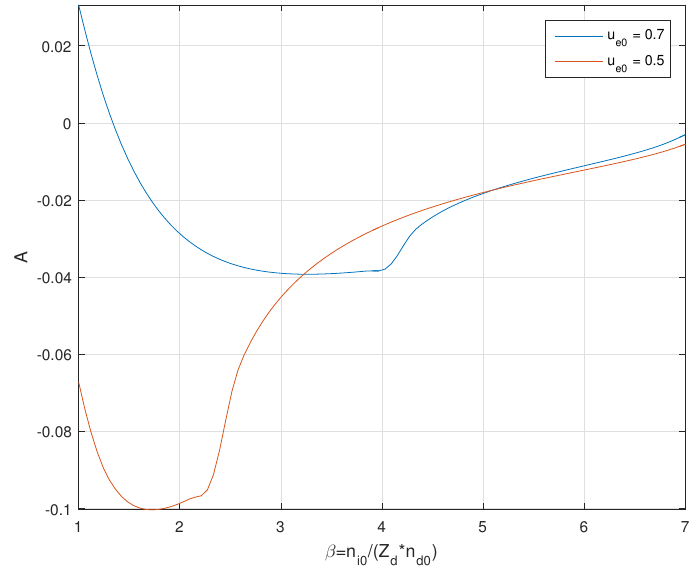
Figure 13. The variation of nonlinear coefficient A with β